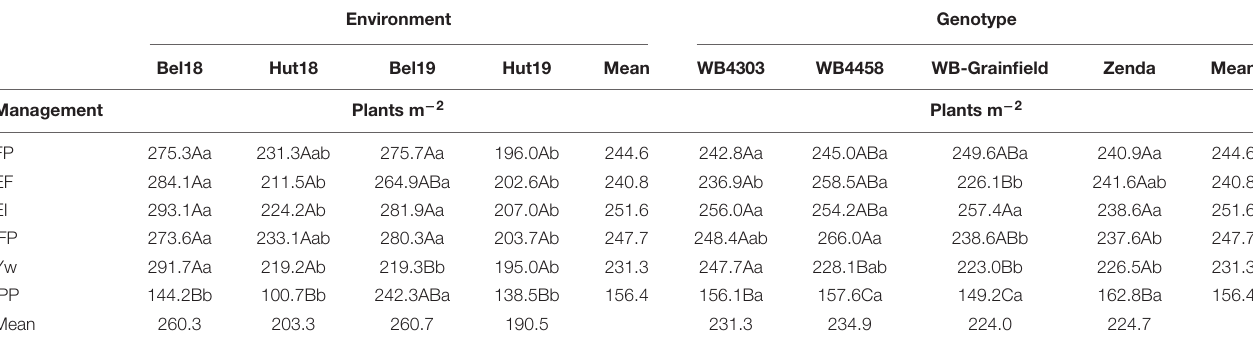
TABLE 4 | Least square mean winter wheat plants m − 2 as affected by management practices (FP, EF, EI, IFP, Yw, and IPP), environments (Bel18, Hut18, Bel19, and Hut19) and